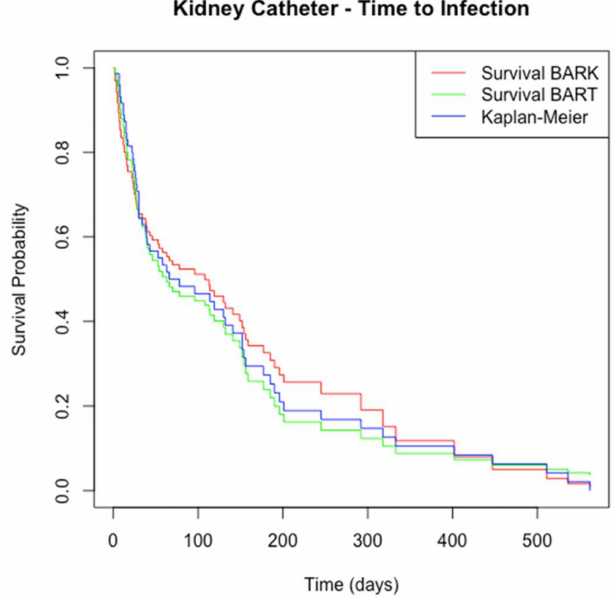
Figure 4. Estimated survival probability curves for the kidney catheter dataset by survival BARK, survival BART, and Kaplan–Meier